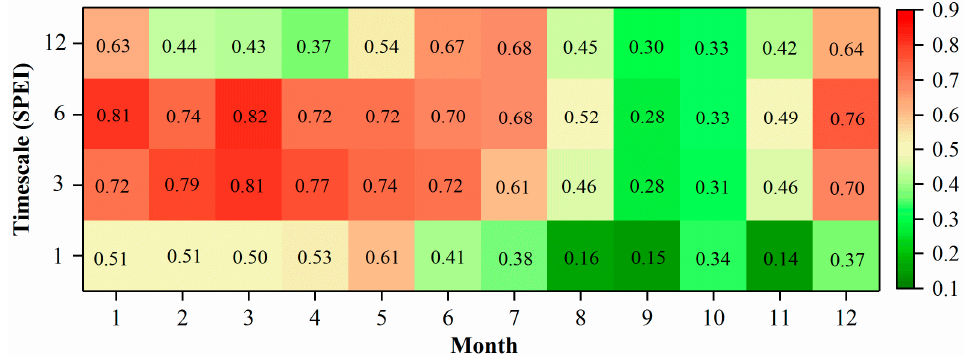
Figure 11. Correlation coefficients between the monthly lake level at Xingzi station and the SPEI values at different timescales.